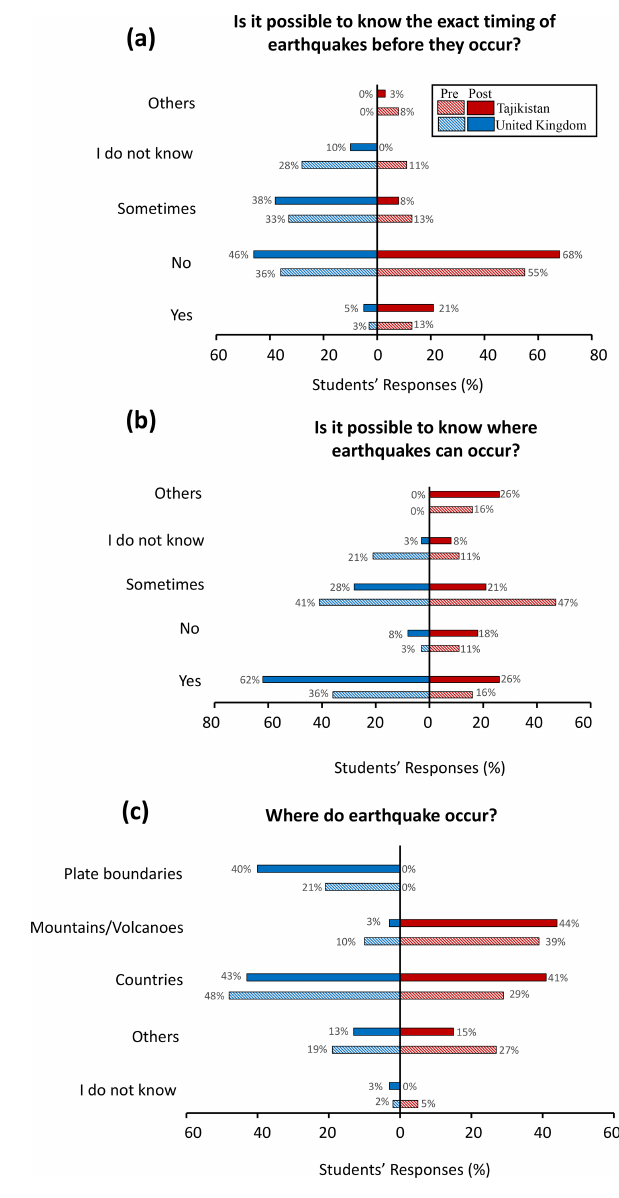
Figure 7. Students’ understanding of earthquake prediction, includ- ing earthquake timing (a) , location (b) , and where in the world earthquakes occur most often (c)